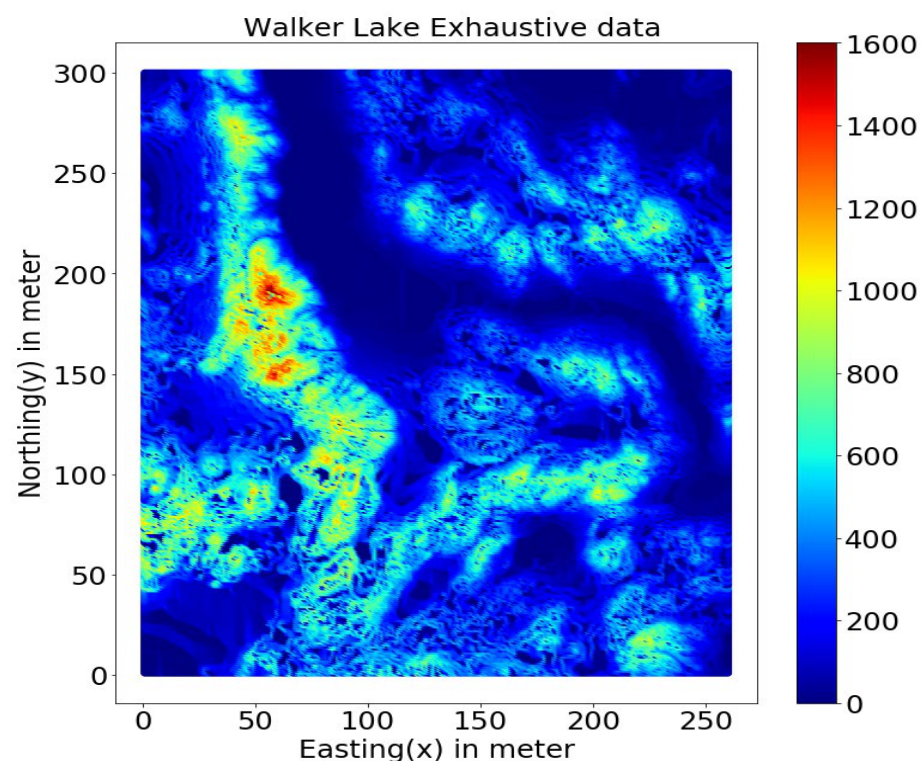
Figure 3. Walker Lake exhaustive data.